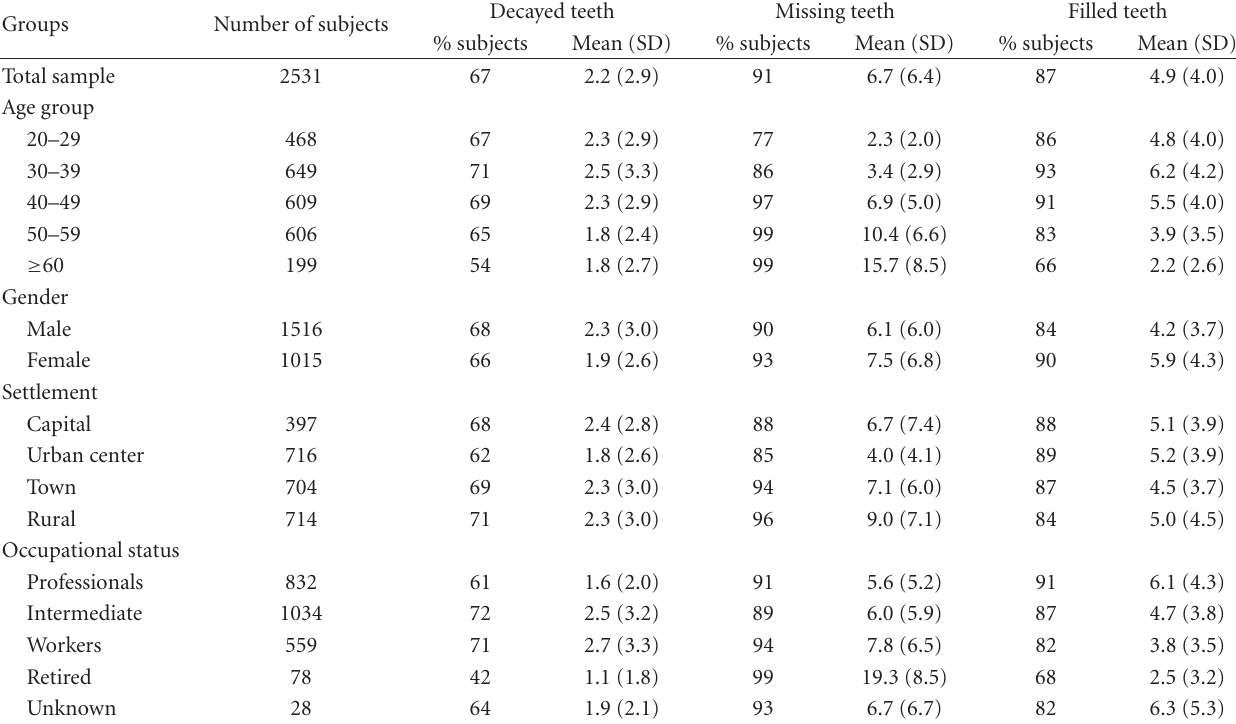
Table 2: Distribution and mean number ± standard deviation (SD) of “decayed,” “missing,” and “filled” teeth according to sociodemograph- ic characteristics of the study